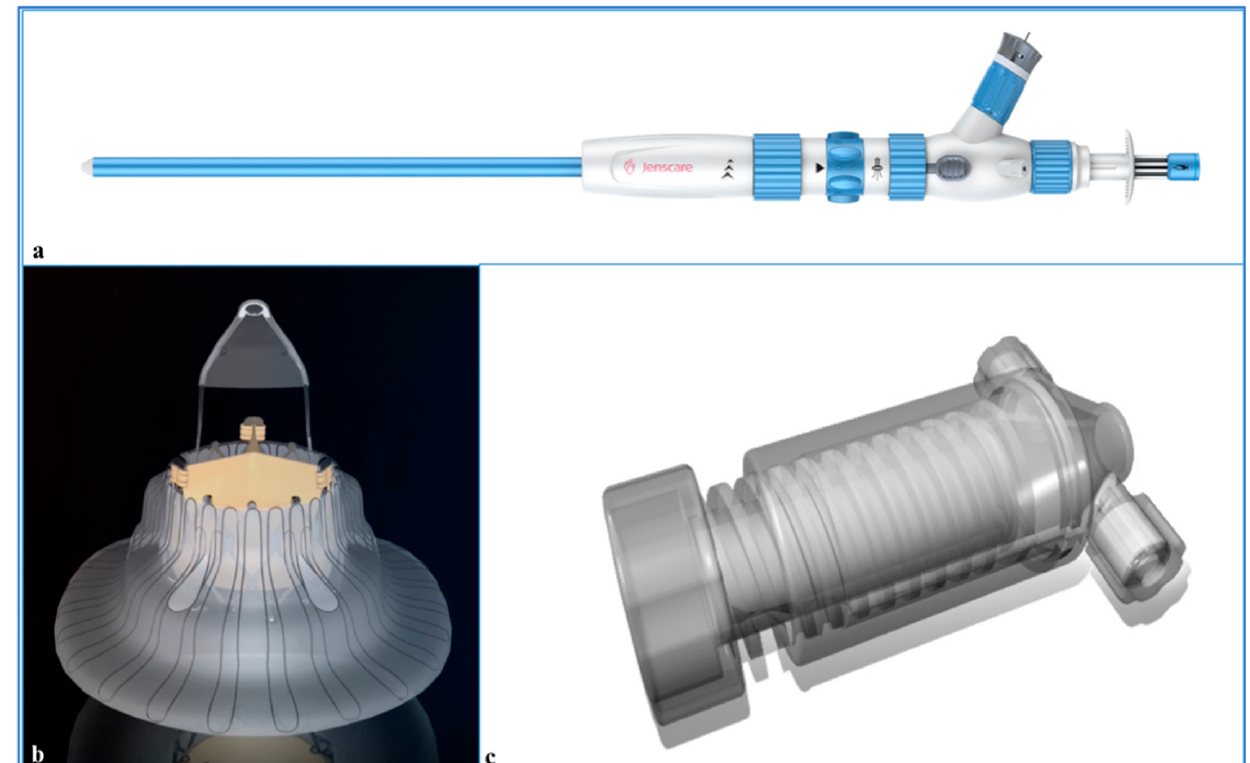
Figure 1. The Lux-Valve is a self-expanding valve. The stent is made of a nickel–titanium alloy, and the biological leaflet is bovine pericardium. The prosthesis is implanted via the right atrial approach and firmly fixed in the tricuspid annulus with its unique anchor device. The large annulus of the prosthesis is located in the right atrium, which also prevents paravalvular leakage. The sheath is 32 Fr, with an adjustable bending function. ( a ) The delivery system of the Lux-Valve; ( b ) right atrial view of the Lux-Valve; ( c ) the loading system of the Lux-Valve.